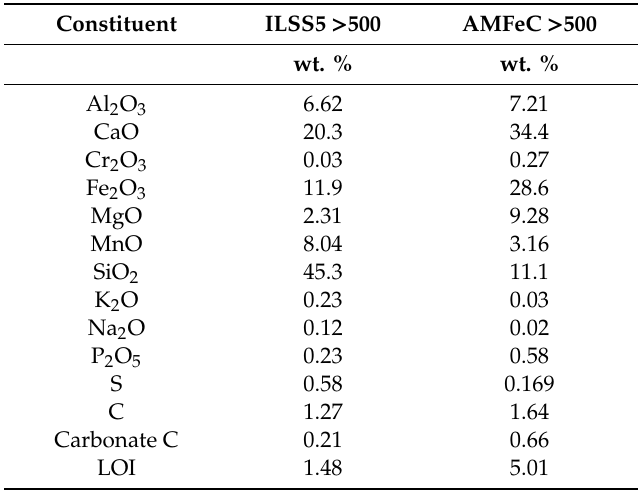
Table 3. Chemistry of ferrous slag samples from the Chicago-Gary area, Illinois and Indiana, used in the column experiments based on wavelength dispersive X-ray fluorescence spectroscopy (WDXRF) for all elements except C and S, which were analyzed by LECO furnace. Constituent ILSS5 >